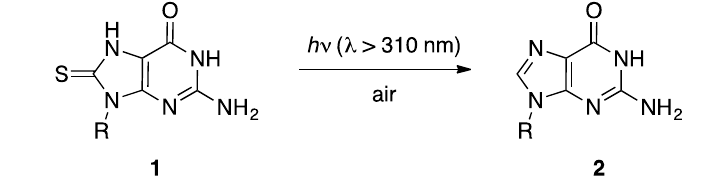
Figure 2. ( a ) UV spectra of 8-TG (c = 1.8 × 10 − 4 M) in air-equilibrated aqueous solution before (black) and after 240 min. Irradiation at λ = 313 nm, ( b ) Chromatogram of the solution of 8-TG before (red) and after irradiation (black). Scheme 2. The formation of Guo ( 2 ) upon excitation of 8-TG ( 1 ).